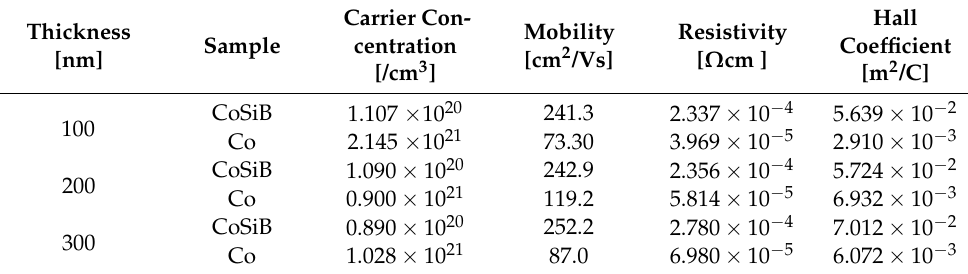
Table 1. The results of room temperature Hall measurements with the CoSiB TFMG and pure Co